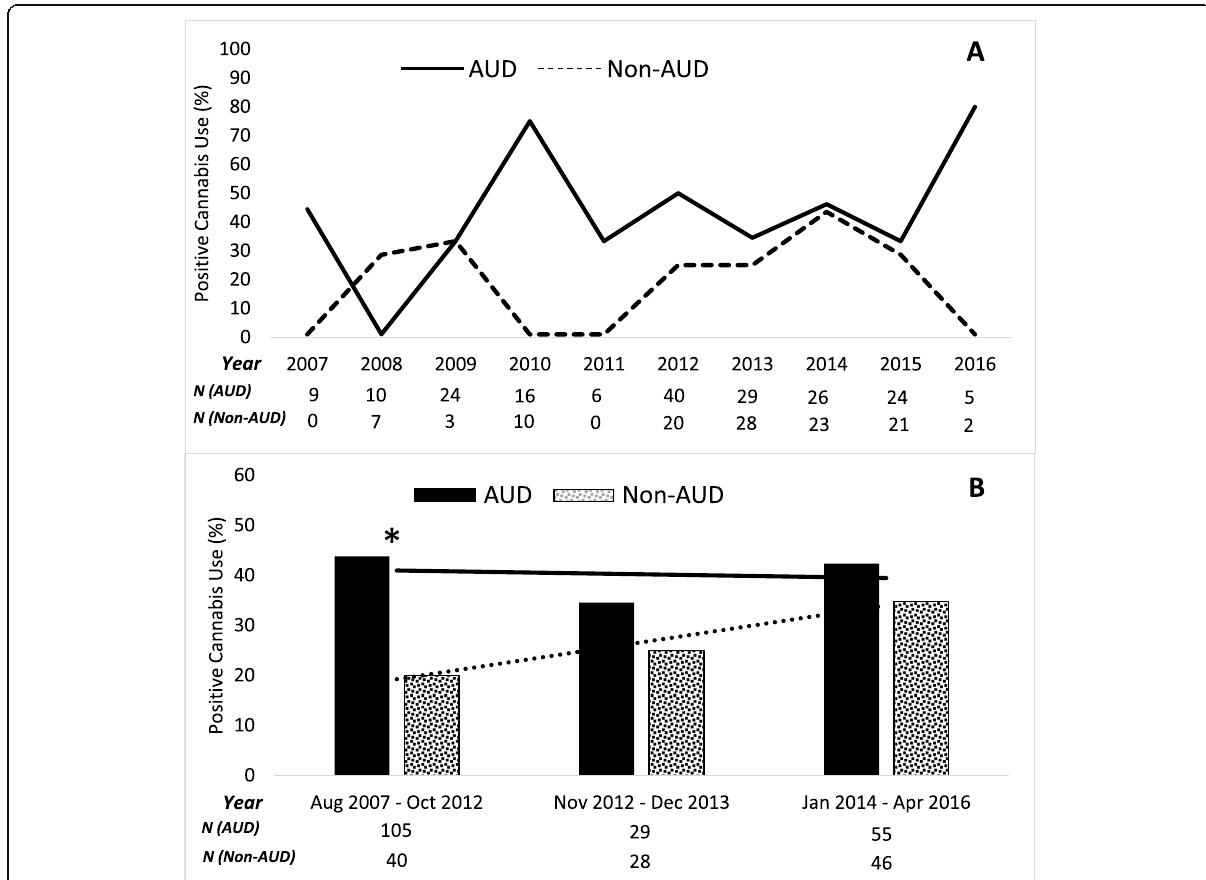
Fig. 1 Cannabis use in Denver, Colorado among participants with likely alcohol use disorders (AUDs) compared to participants with low risk alcohol use (Non-AUD) during a each year of study enrollment from 2007 to 2016; and b three time-intervals of study enrollment corresponding to pertinent legislative change: prior to cannabis legalization for recreational use (August 2007 to October 2012), after legalization for recreational use (November 2012 to December 2013), and after legalization for sales by retail businesses (January 2014 to April 2016). *Denotes significant group differences in cannabis use ( p = 0.006 by Chi-square analysis) for the specified time-interval